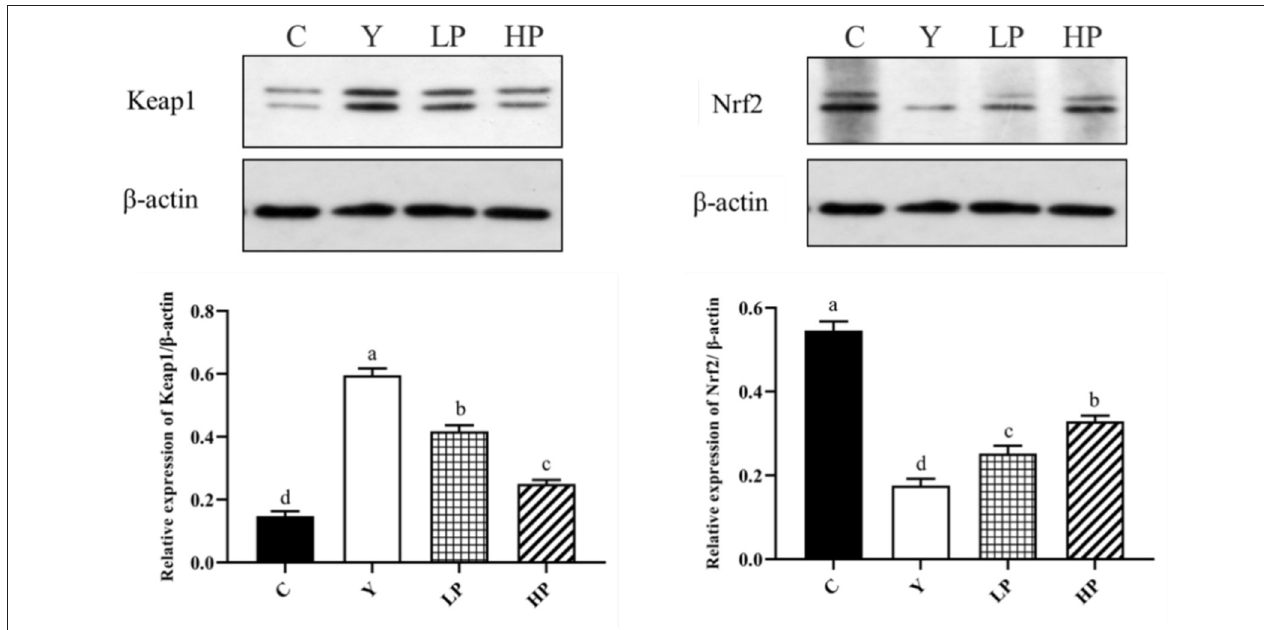
FIGURE 7 | Effects of OP on Keap1-Nrf2 signaling pathway in the ileum of oxidative injured mice. Different letters in the figure represent significant differences ( P < 0.05). C: the normal group; Y: the Cy-induced group; LP: Cy + 200 mg/kg OP; HP: Cy + 400 mg/kg